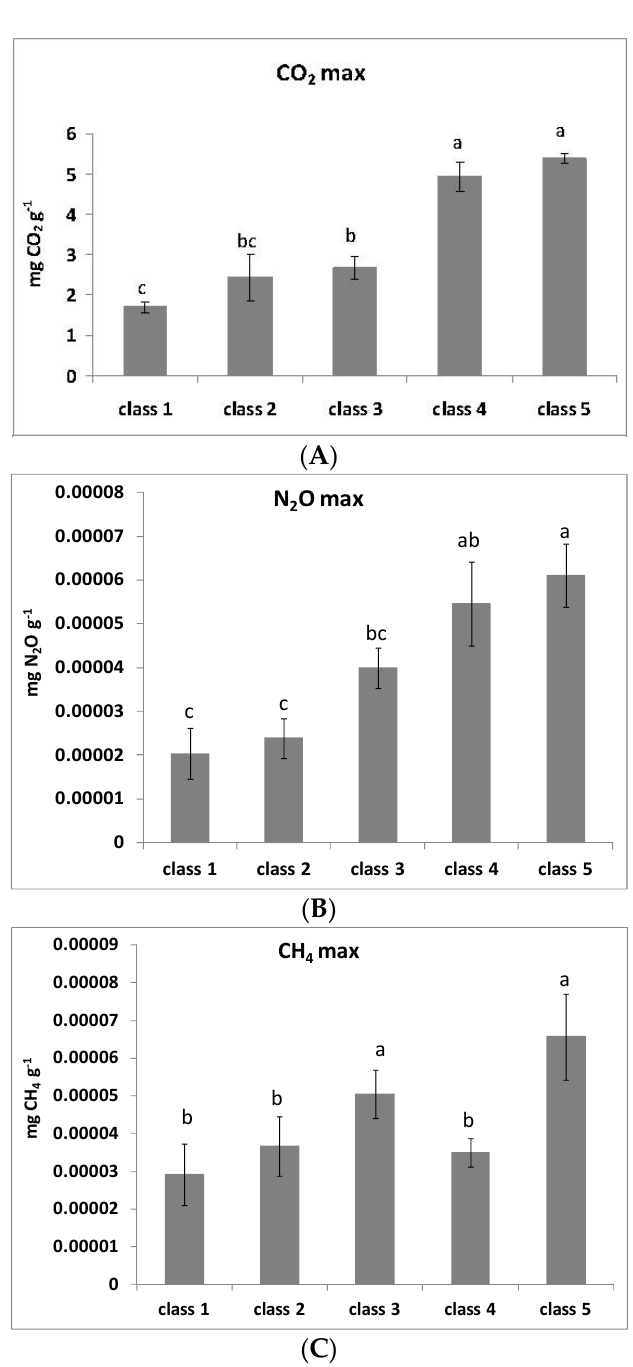
Figure 1. Maximum values CO 2 ( A ); N 2 O ( B ); and CH 4 ( C ) production from the black pine deadwood of the five different decomposition classes. Vertical bars indicate standard errors of means ( n = 4). Different letters indicate significant differences at p < 0.05 among means.